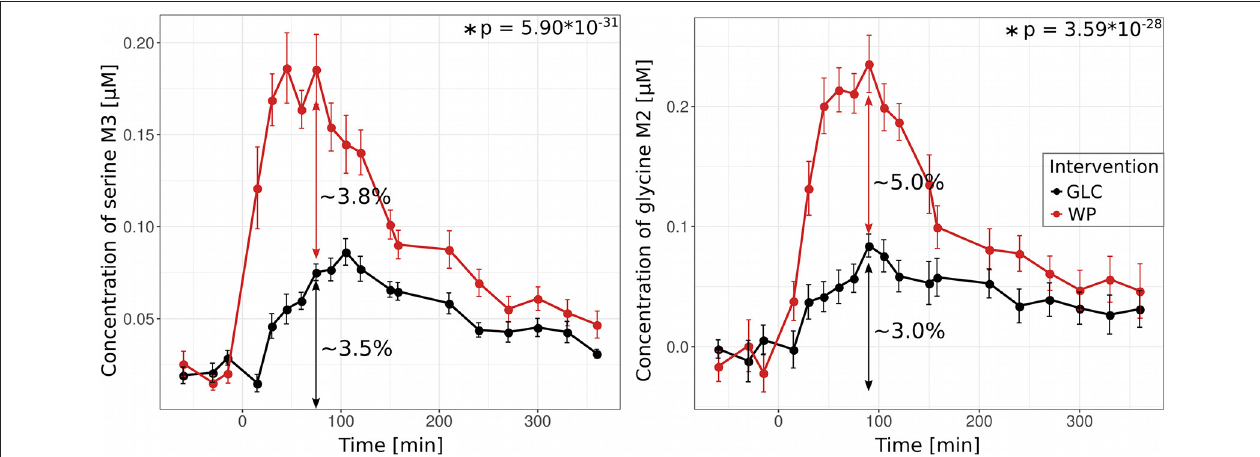
FIGURE 6 | Protein-derived serine and glycine contribute to the plasma pool. Concentrations of 13 C-labeled isotopologues serine M3 and glycine M2 after glucose (GLC, black) and wheat porridge (WP, red) intake; displayed is the average of eleven subjects ± standard error of the mean (SEM), statistics: rmANOVA.